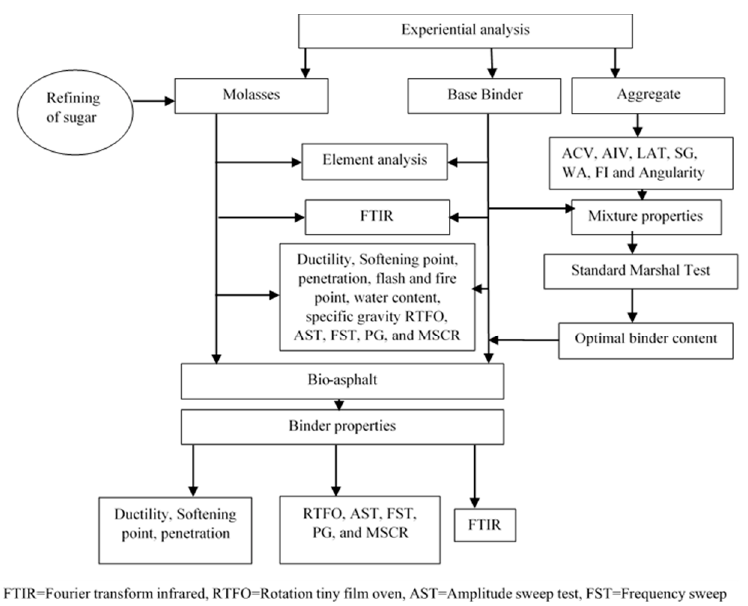
Figure 2. Flow chart of the research study.